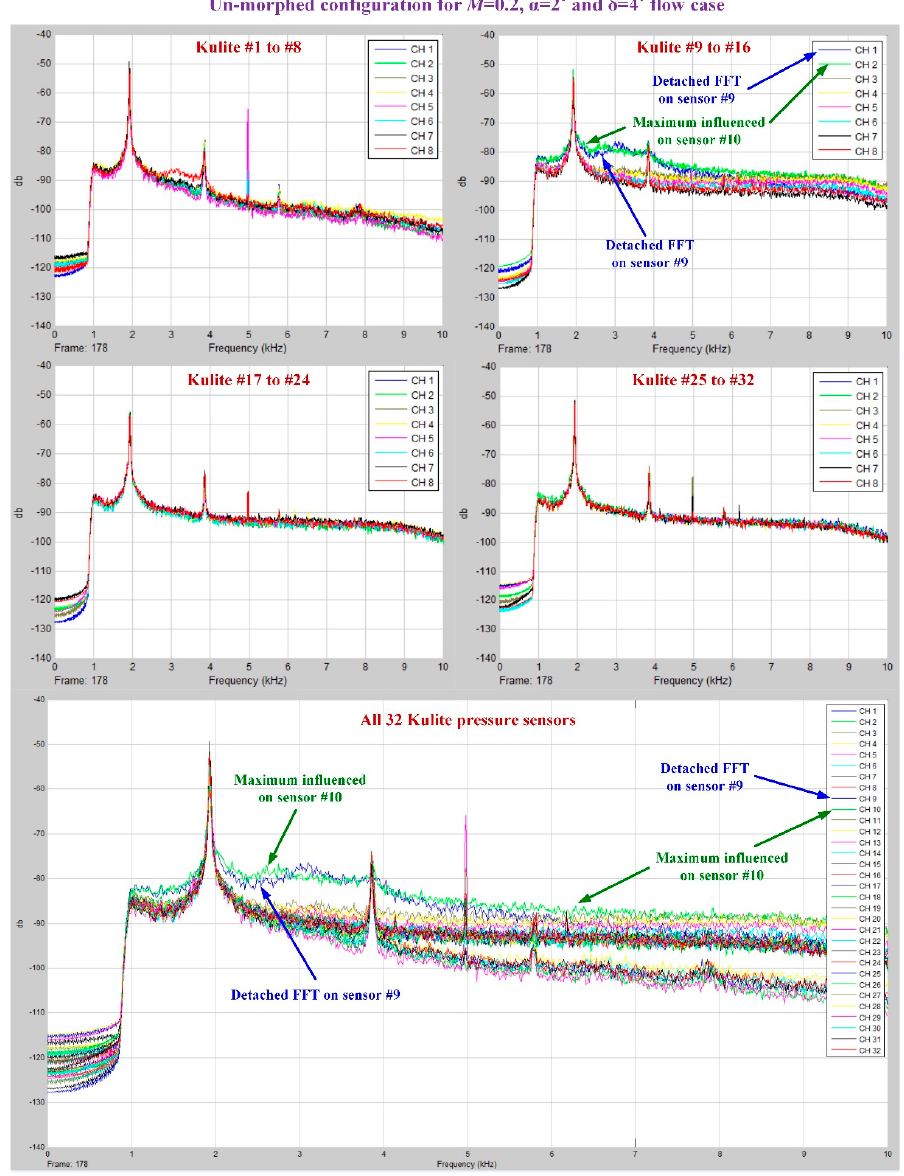
Figure 18. Fast Fourier transform (FFT) results for the wing un-morphed configuration in M = 0.2, α = 2 ◦ , and δ = 4 ◦ flow conditions.